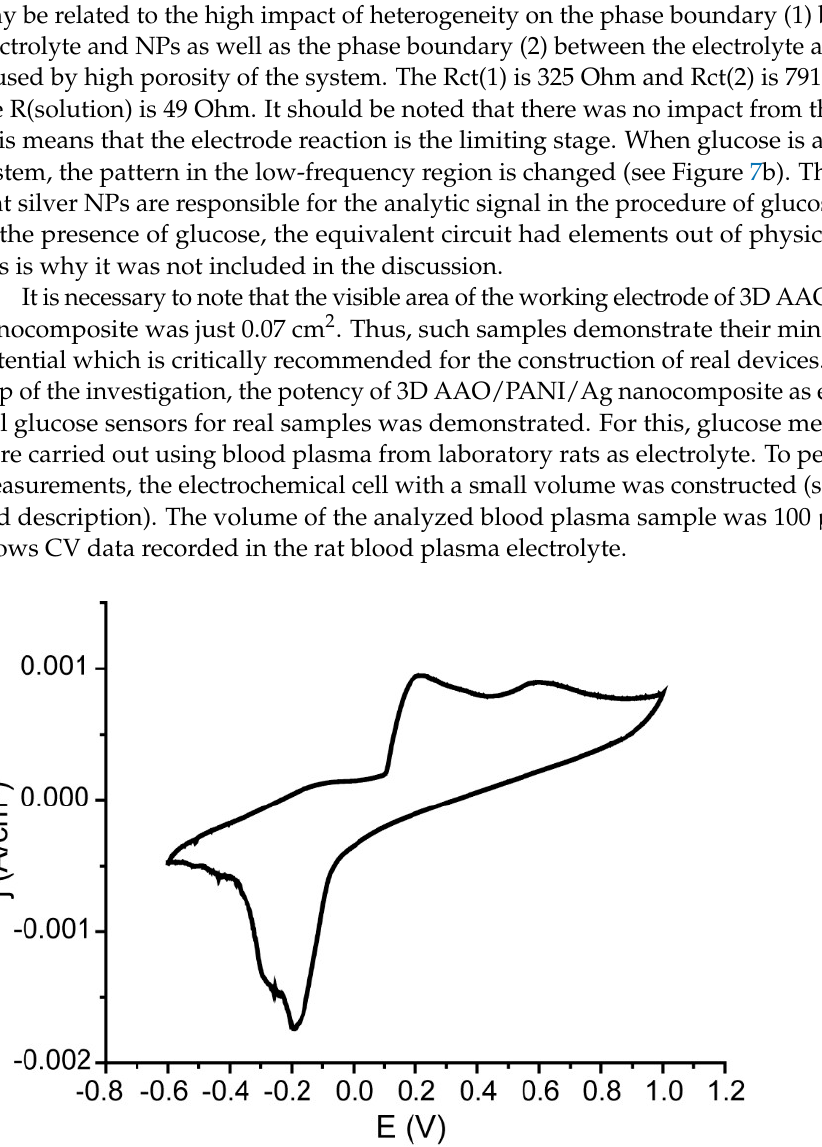
Figure 8. CV for glucose detection in rat blood plasma on AAO/PANI/Ag nanocomposite.